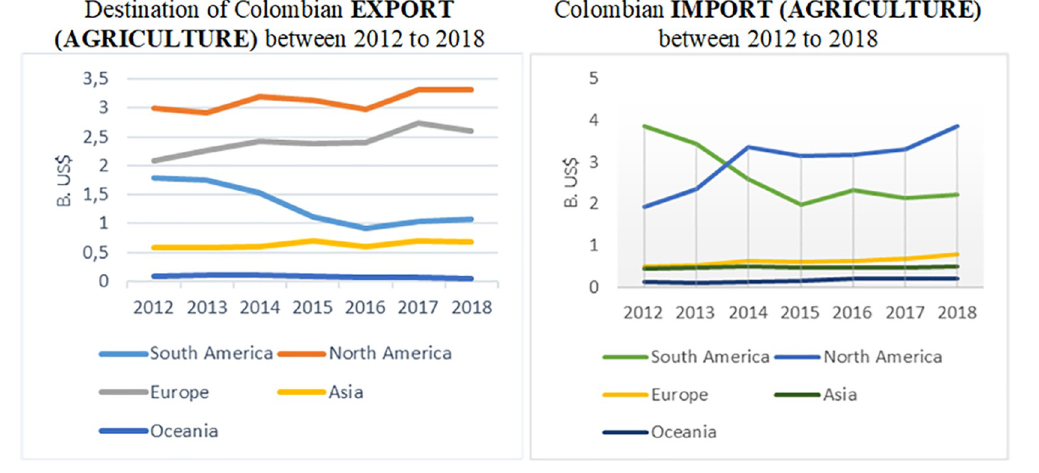
Fig 2. Colombian agricultural trade 2012–2018. Source: Prepared by the author, based on data from The Atlas of Economic Complexity [31].